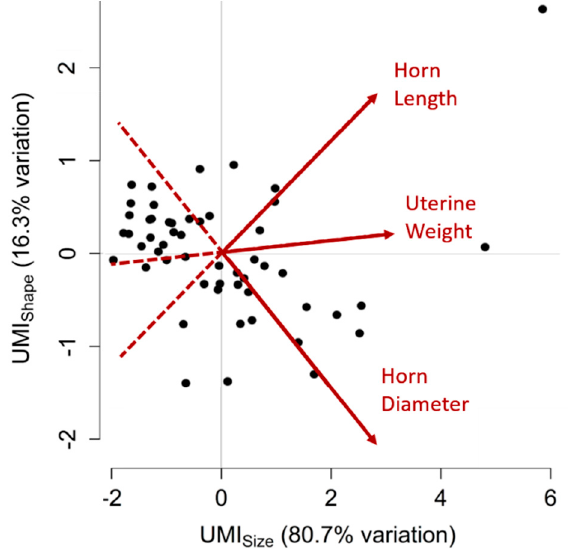
Figure 1. Principal component analysis for uterine traits. Two variables, or Uterine Mass Indices (UMIs), UMI size and UMI shape , were created to summarise uterine weight, horn length and horn diameter measurements for each gilt. The two UMIs cumulatively account for 97.0% of the variation observed between uteri. Higher UMI size values correspond to uteri with greater uterine weight, horn length and horn diameter, whereas higher UMI shape values correspond to uteri with greater horn length and uterine weight and lesser horn diameter. Each point on this graph represents a uterus, plotted according to their two UMI values. Points distributed towards the arrowheads of the red vectors have greater measurements of the corresponding uterine trait (labelled in red) than points located towards the tail-end of the vectors. Positively correlated traits have vectors that point in the same direction, negatively correlated traits have vectors that point in opposite directions and traits that have no correlation have vectors that are perpendicular to each other.